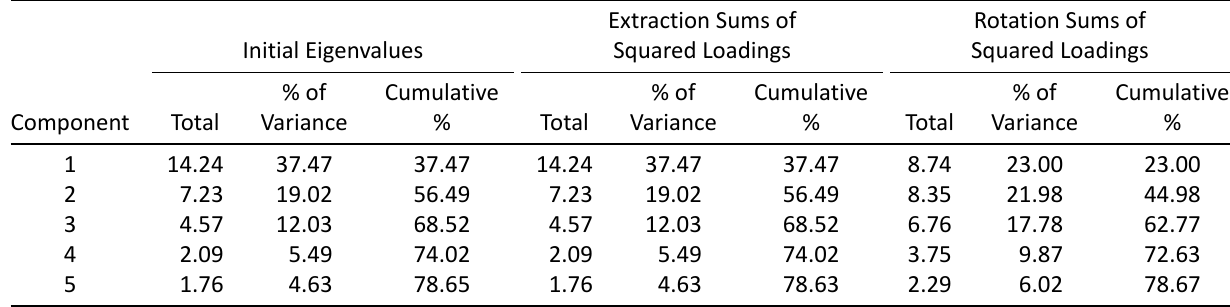
Table 5. Total variance explained showing eigenvalues and loadings used to extract principal comments.